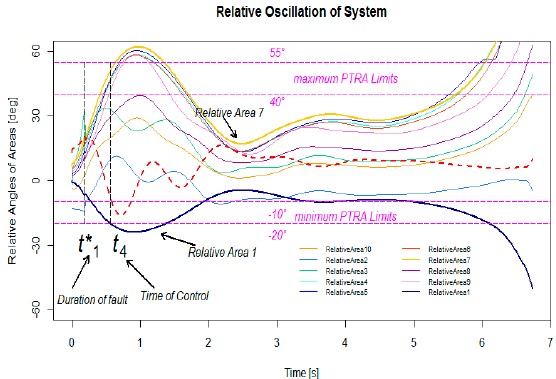
Figure 7. Relative oscillation of the power system for a three-phase fault in Line 4-5 cleared at 0.19 s.